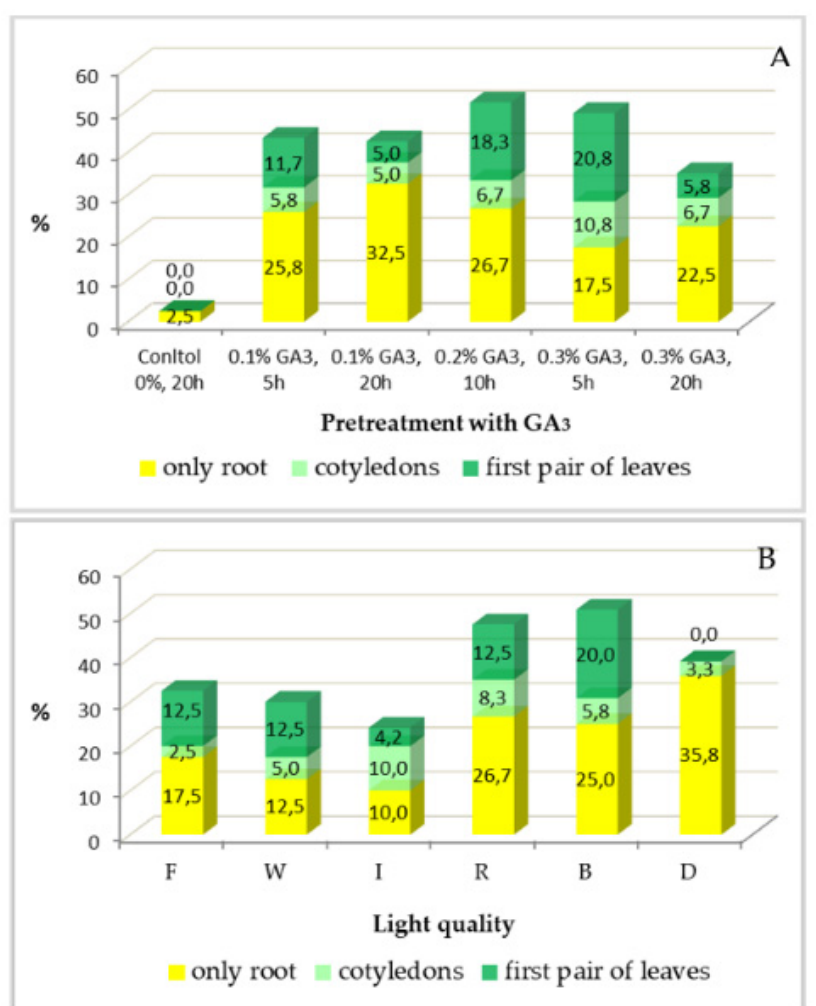
Figure 2. Percentages of germinated seeds and seedlings of P. veris at early stages in the groups of treatment variants with equal levels of the factors: ( A ) GA 3 -pretreatment; ( B ) light quality (F—fluorescent white; W—white LED; I—infrared; R—red; B—blue; D—darkness).